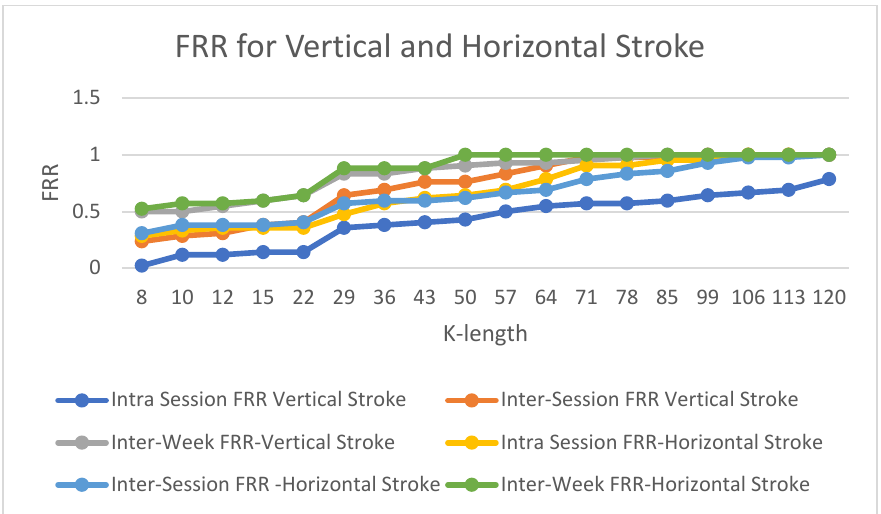
Figure 7. The results of FRR on the Touchalytics dataset with respect to K-length with the third experiment.